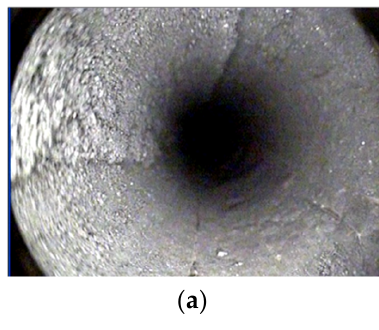
Figure 18. Roadway surface displacement monitoring. ( a ) station 1; ( b ) station 2.